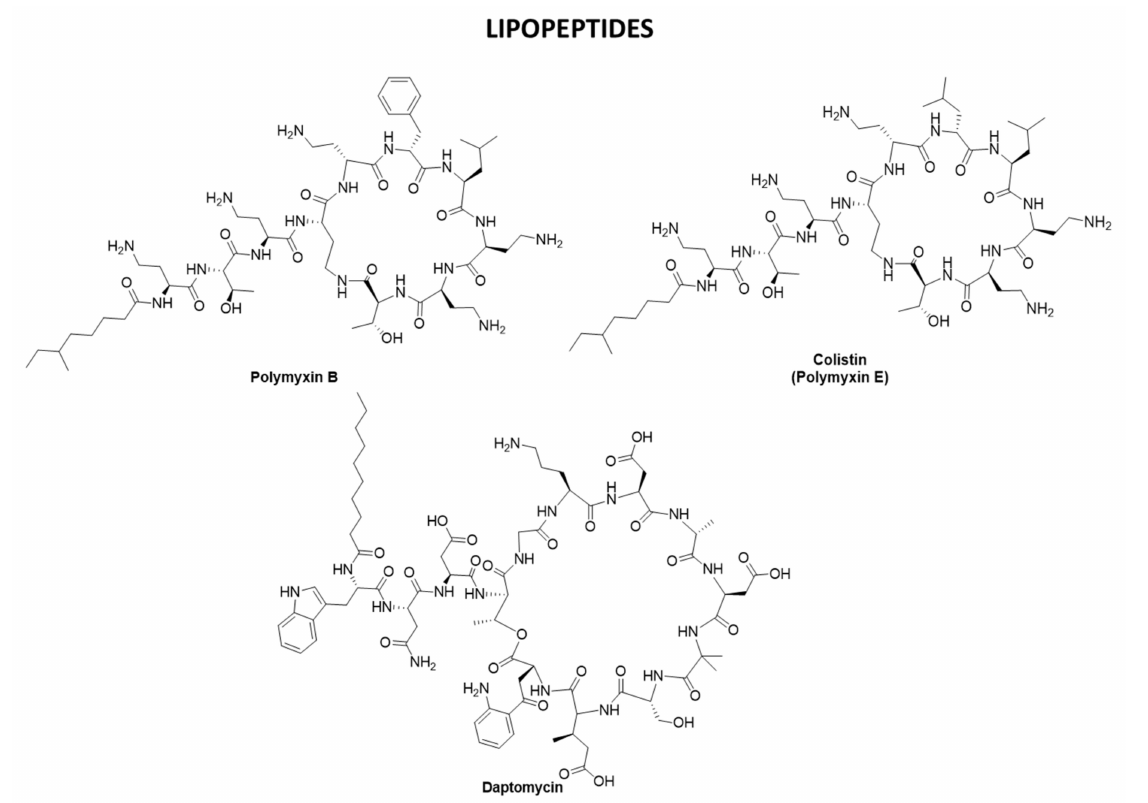
Figure 13. Structure of polymyxin B, colistin (polymyxin E), and